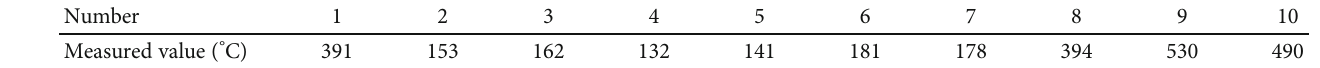
Table 2: Test values of piston temperature fi eld.